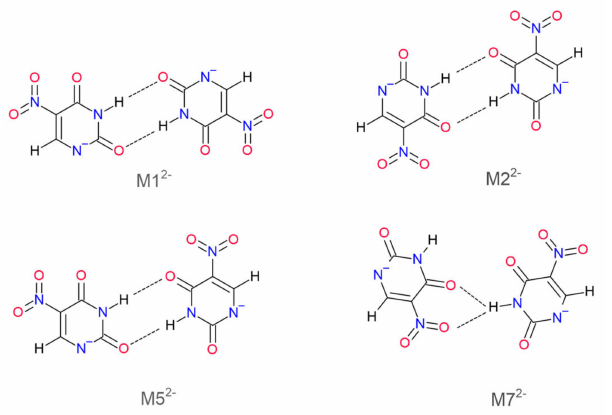
Figure 3. Typical H-bonding schemes with the negative ion, 5NU − The same tags of Figure 2 were used for equivalent bonding schemes, for easy comparison, adding the overall charge in